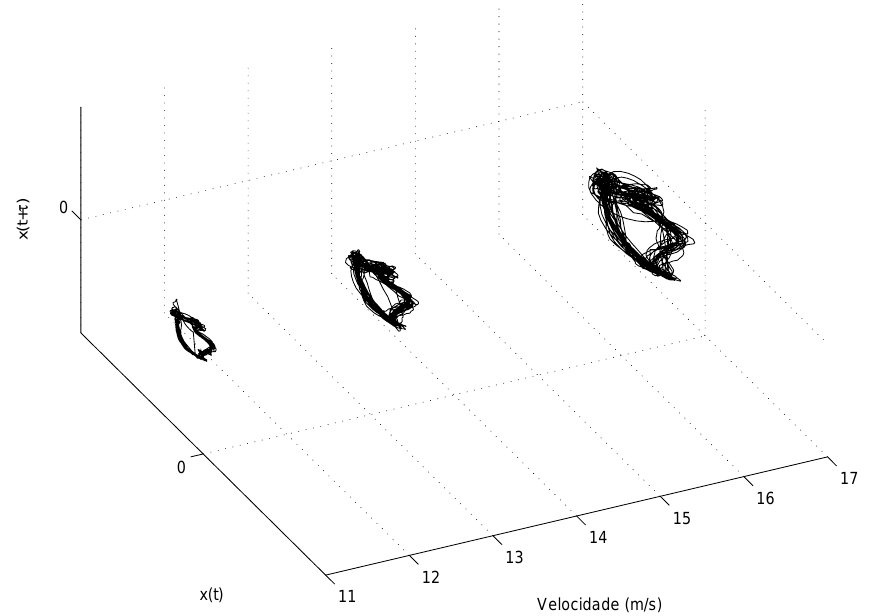
Fig. 5. Reconstructed state spaces of bending measurements with freestream velocity variation (cases 2, 4 and 6 from Table